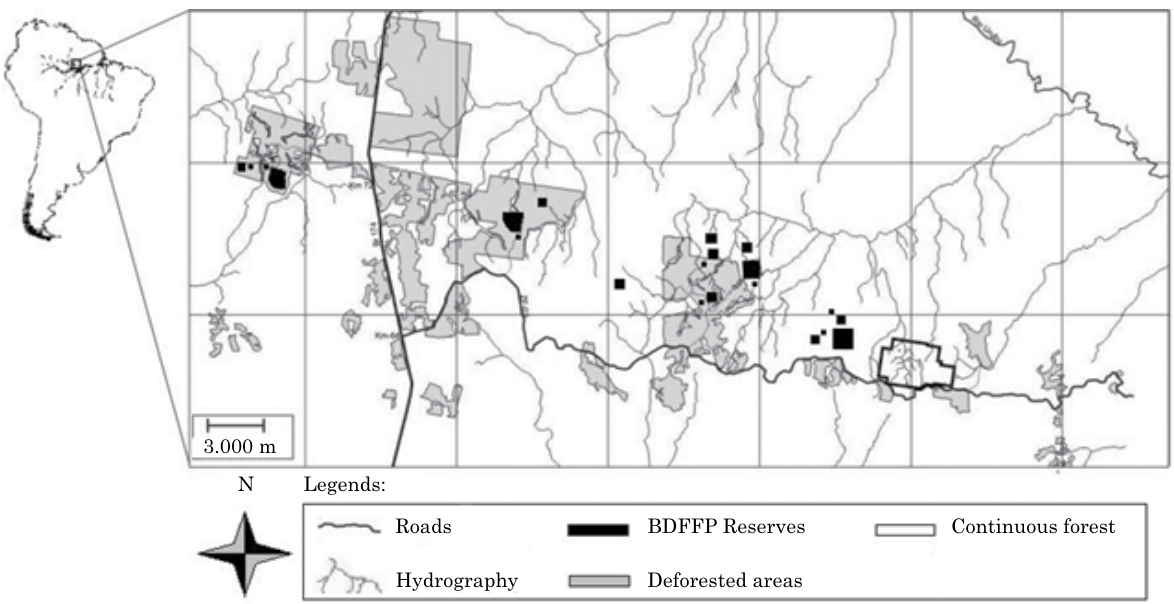
Figure 1. Study area. Source: Project Biological Dynamics of Forest Fragments